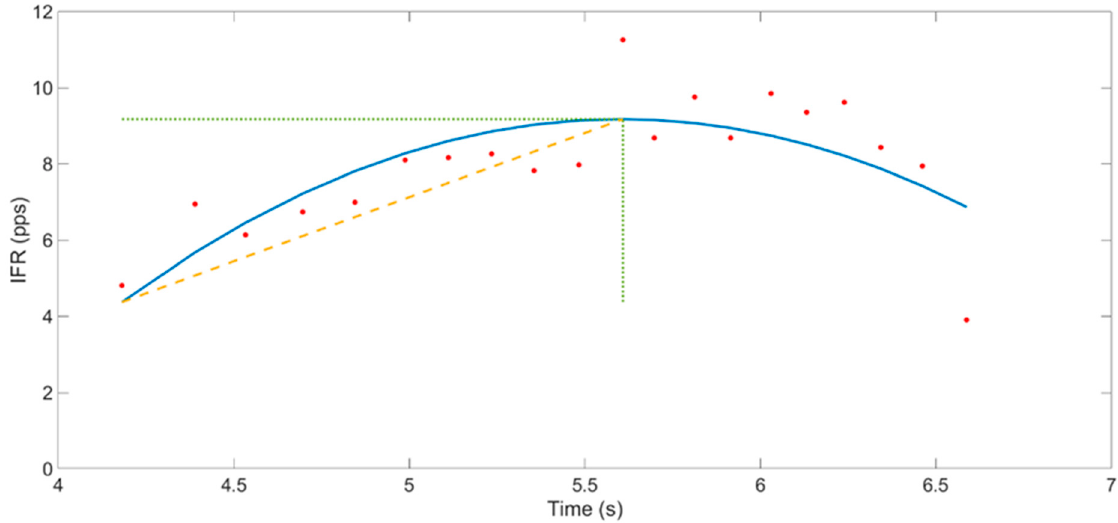
Figure 6. Representation of the instantaneous motor unit(MU) firing rate gradient (IFRG). The blue line depicts the 2nd order polynomial fitted to the IFR, pictured in red dots. From this polynomial, the peak IFR was retrieved (dotted green line) and then used to compute the linear expression from the first detected IFR value to the peak IFR (yellow line).